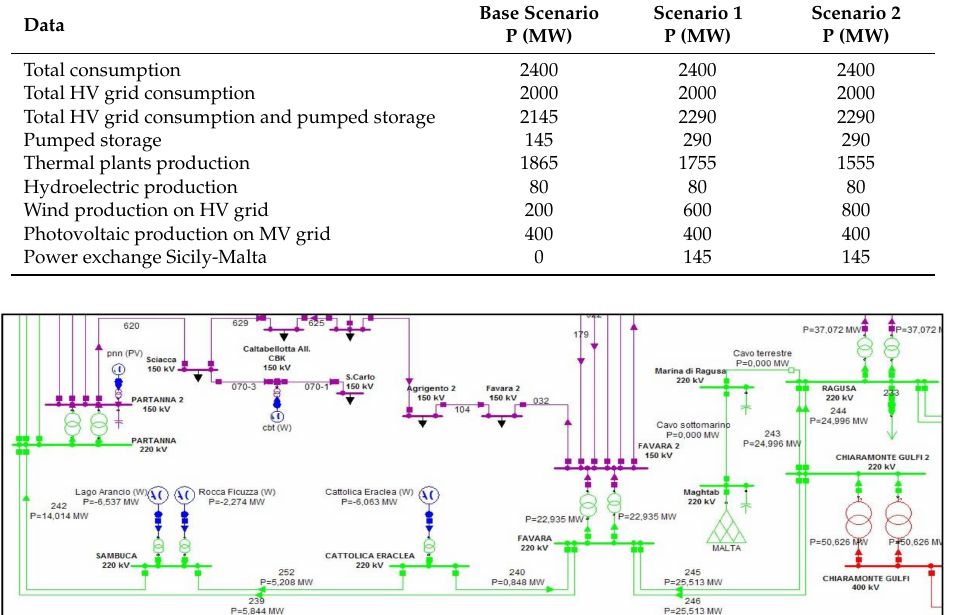
Figure 2. Base Scenario—Power flows on the portion of the network near the submarine interconnection connected to Ragusa